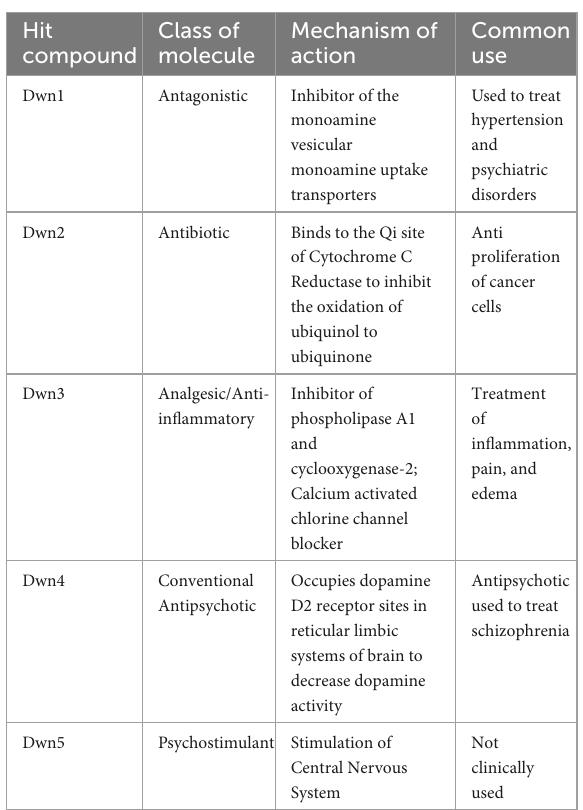
TABLE 1 Identified hit compounds and their mechanism of